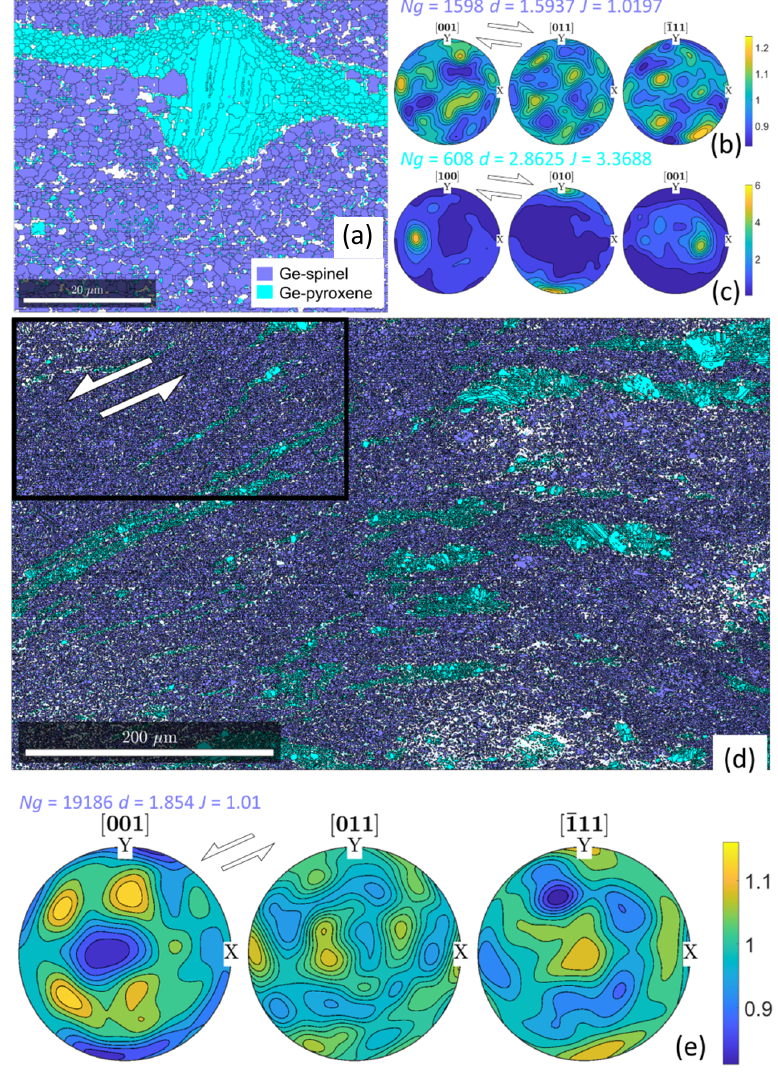
Figure 8. EBSD maps of shear bands on sample G15. ( a ) Shows a phase map with grain boundaries in black. ( b ) and ( c ) show corresponding pole figures for Ge-spinel and Ge-pyroxene, respectively. Number of grains used, Ng, average grain size, d, and the J index (i.e., texture strength) are given above. ( d ) Phase map with grain boundaries in black. The black rectangle, in the core of the shear zone, shows the area used for pole figure analysis. ( e ) Pole figures of Ge-spinel.